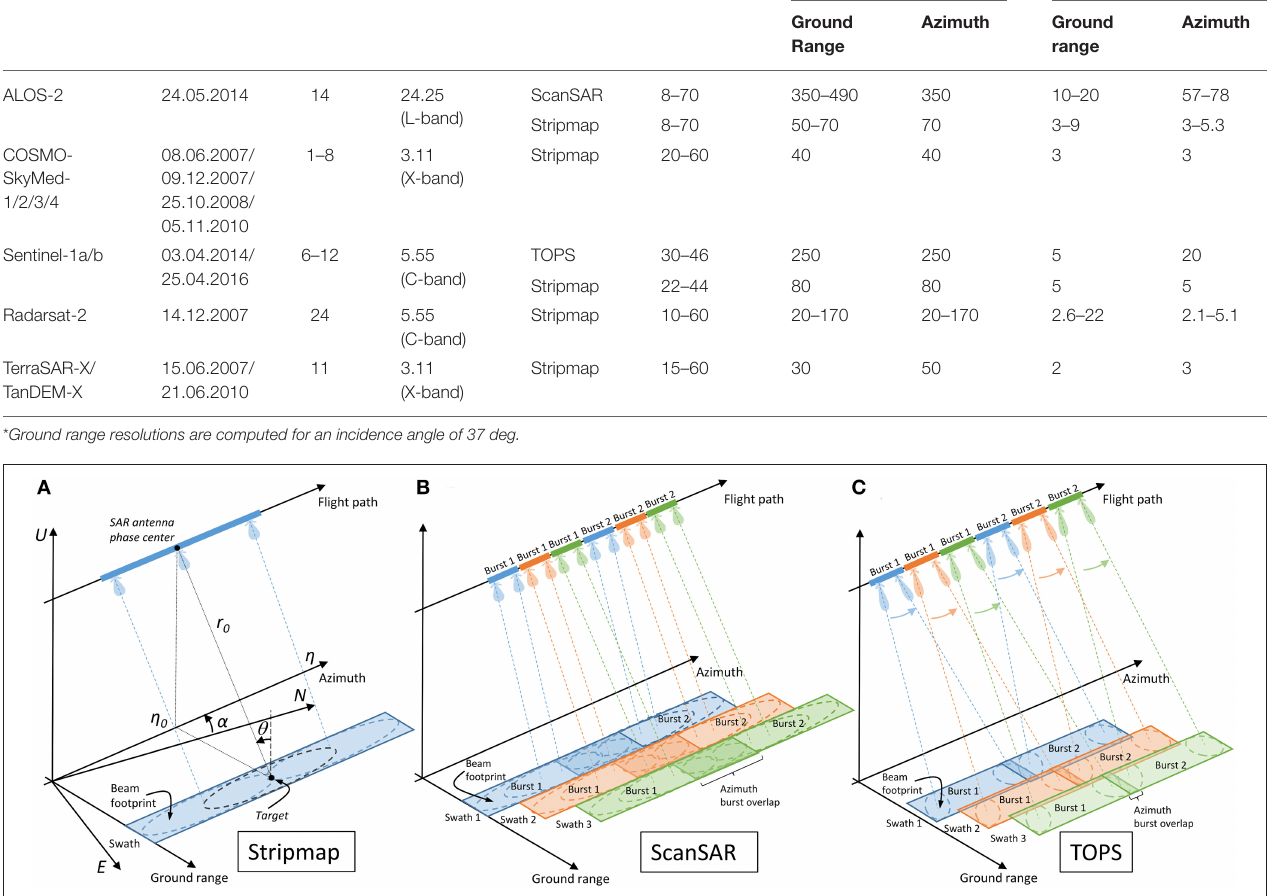
FIGURE 1 | SAR acquisition geometries. (A) Stripmap (B) ScanSAR with three range swaths and two azimuth looks (C) TOPS with three range swaths, such as the Sentinel-1a/b Interferometric Wideswath (IW) mode. The symbols which appear in (A) are described in section Sensitivity to